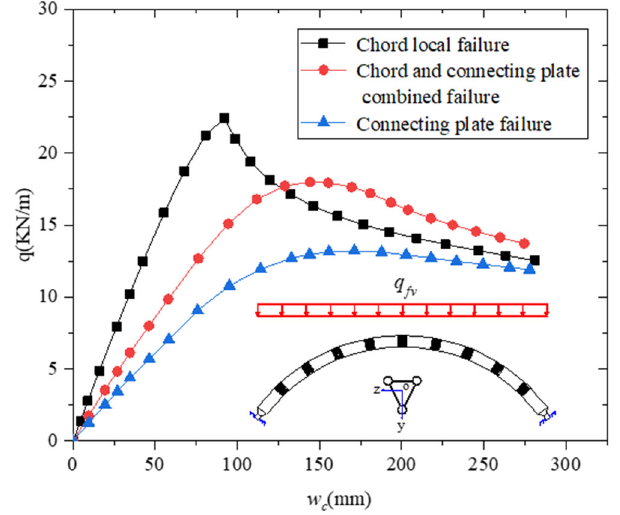
Figure 27. Comparison of load–displacement curve for three types of local failure modes.